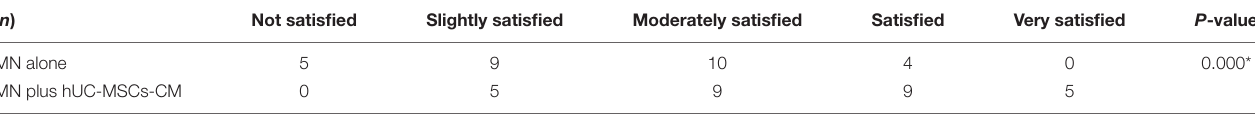
TABLE 2 | Participant’s overall satisfaction with the efficacy at 2 weeks after the last treatment. ( n ) Not satisfied Slightly satisfied Moderately satisfied